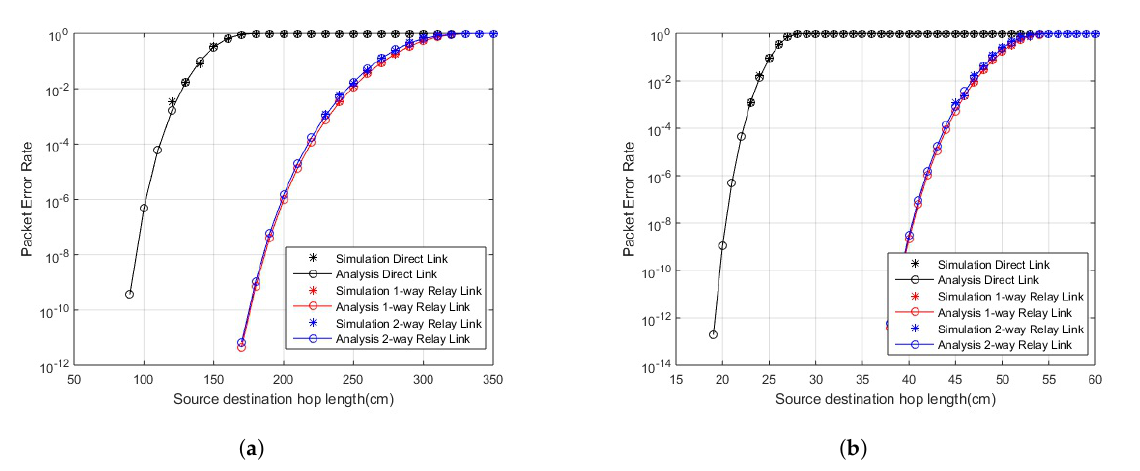
Figure 3. PER for on-body communication; ( a ) PER for on-body line of sight (LOS) communication; ( b ) PER for on-body non line of sight (NLOS)